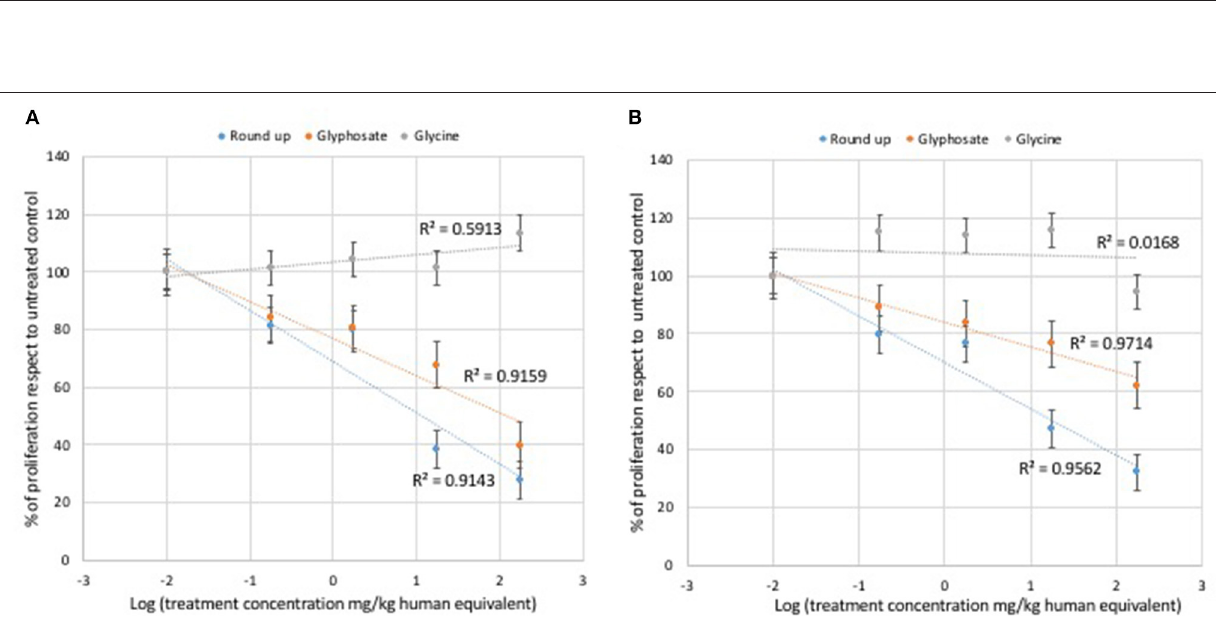
Frontiers in Public Health | www.frontiersin.org